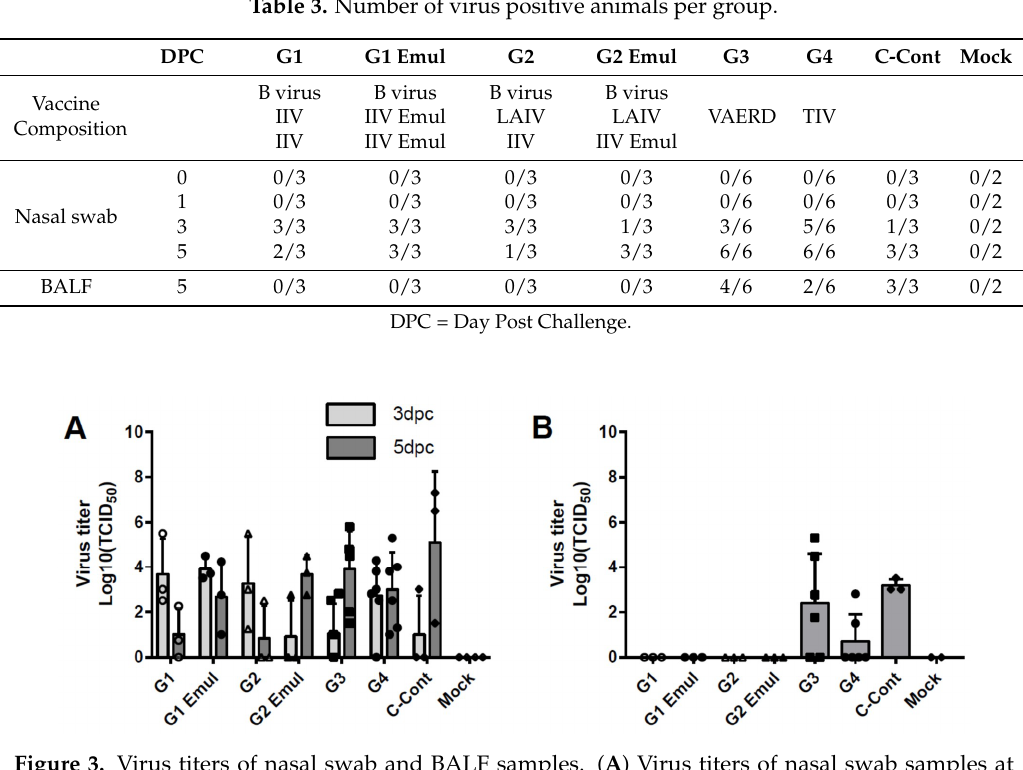
Figure 3. Virus titers of nasal swab and BALF samples. ( A ) Virus titers of nasal swab samples at 3 and 5 dpc. Bars represent means and error bars represent standard deviations ( B ) Virus titers measured in BALF at 5 dpc. Virus titer is presented as TCID 50 /mL. A TCID 50 was calculated using the Reed and Muench method. Bars represent means and error bars represent standard deviations. Open and filled symbols ( △ , □ and ○ ) were used to show individual data points for the different experimental groups.